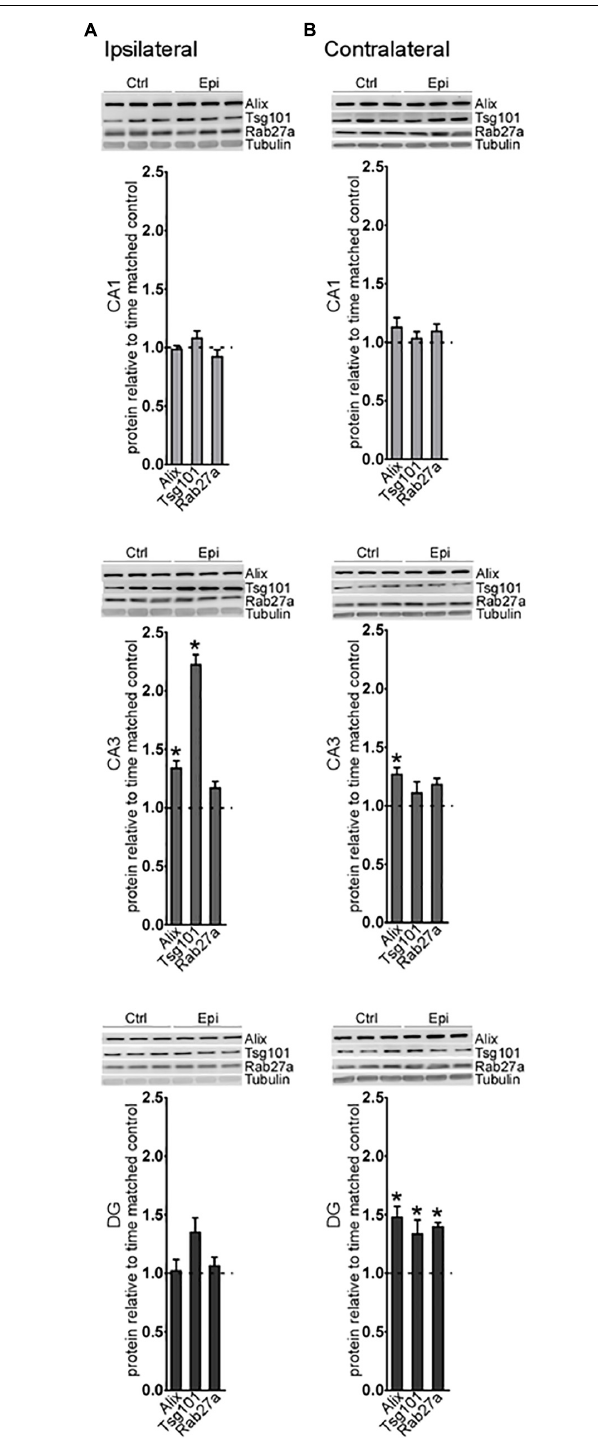
FIGURE 4 | Long-term regulation of exosome biogenesis proteins after status epilepticus in hippocampal subfields. Representative western blots and graphs show levels of a set of exosome proteins in samples obtained 2 weeks after SE for each subfield in the (A) ipsilateral and (B) contralateral hippocampus. Protein levels are normalized to tubulin. Graphs show mean ± SEM. n = 5–6 per group. ∗ p < 0.05, t -test comparing to